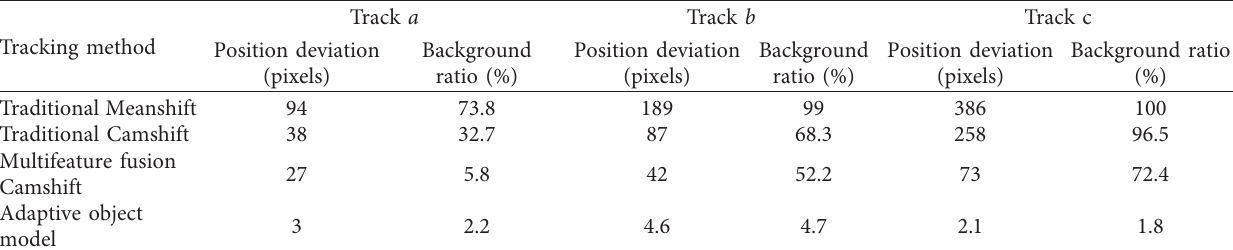
Table 2: Tracking performance comparison.